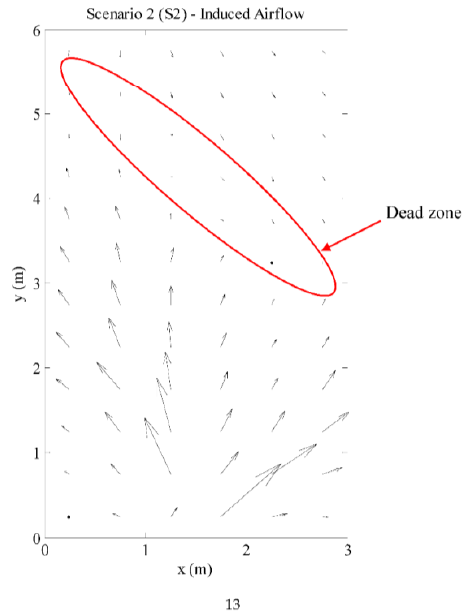
Figure 12. Average airflow in testbed—fan turned on.